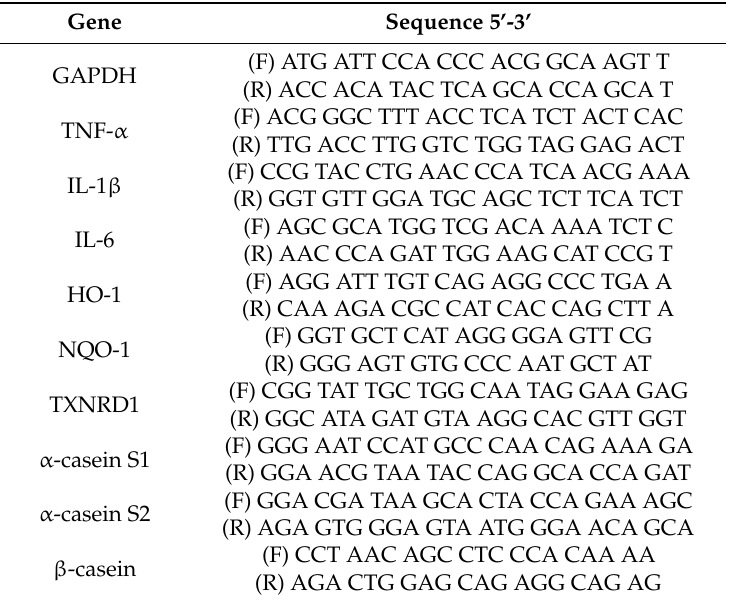
Table 1. Primers used for